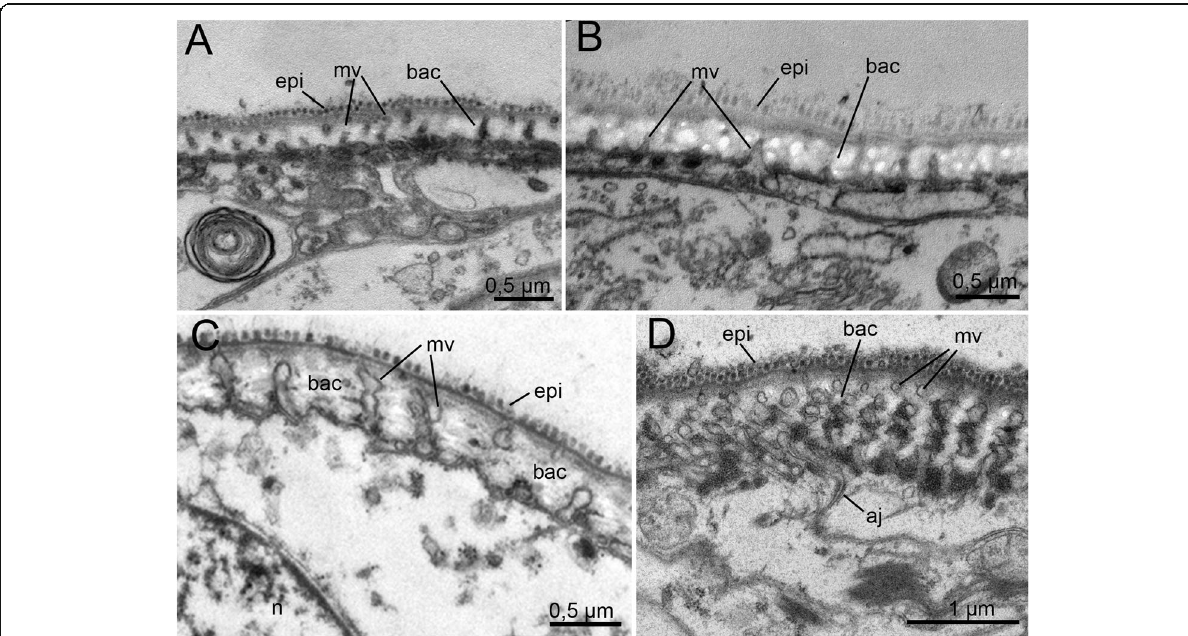
Fig. 11 Fine structure of the juvenile ( a-b ) and adult ( c-d ) external epithelial cuticles of Histriobdella homari . TEM images. aj, adherens junction; bac, basicuticle; epi, epicuticle; mv, microvilli; n,